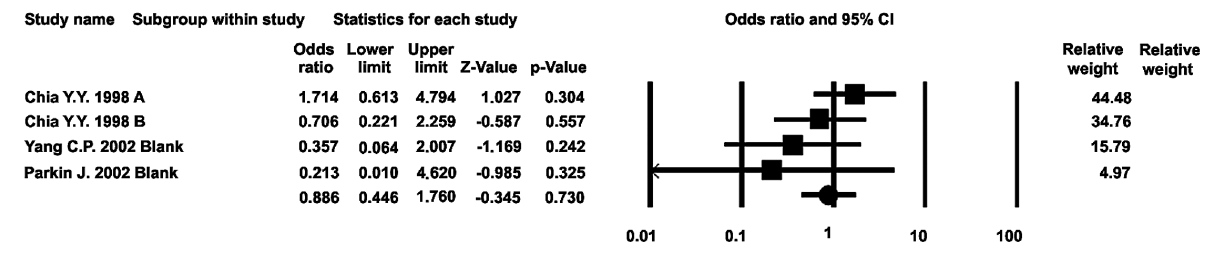
Figure 2 – Meta analysis of non-steroidal anti-inflammatory drugs (NSAIDs) vs. opioid